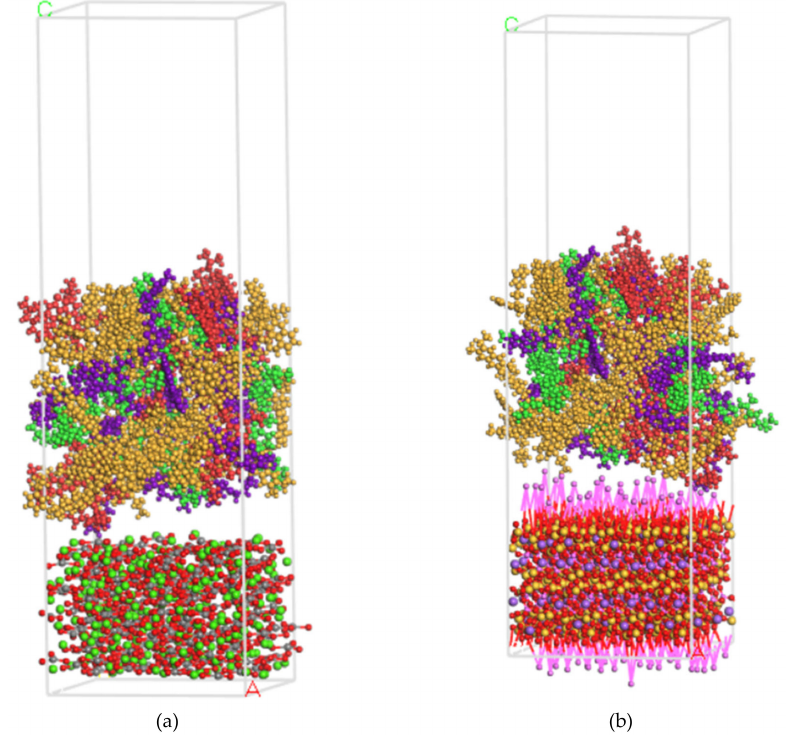
Figure 11. Schematic diagram of asphalt-aggregate model. ( a ) Asphalt-calcite, ( b )